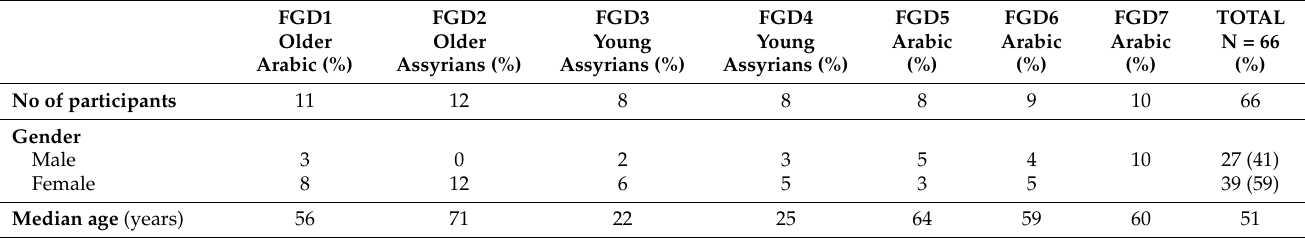
Table 1. Socio-demographic characteristics of FG